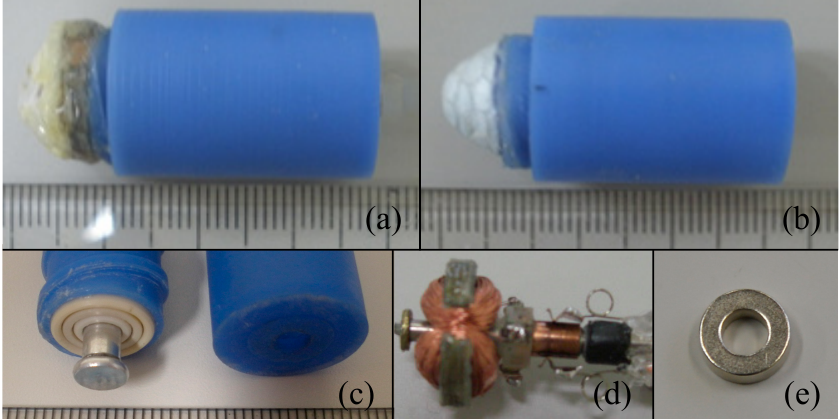
Figure 6. Prototype of the magnetic actuated microrobot with spiral jet motion. ( a ) Electromagnet actuated microrobot; ( b ) Permanent magnetic actuated microrobot; ( c ) Bottom view of the microrobot composed of a bare propeller and a non-rotating nozzle; ( d ) Three-pole rotor as an actuator; ( e ) O-ring type magnet as a actuator.